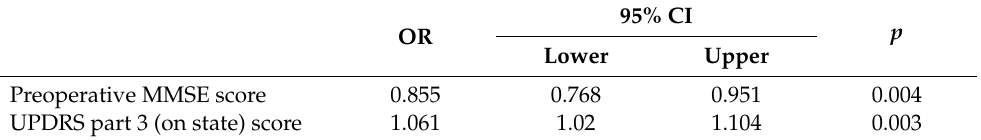
Table 4. Multivariate logistic regression analysis showing the independent predictors of POD.